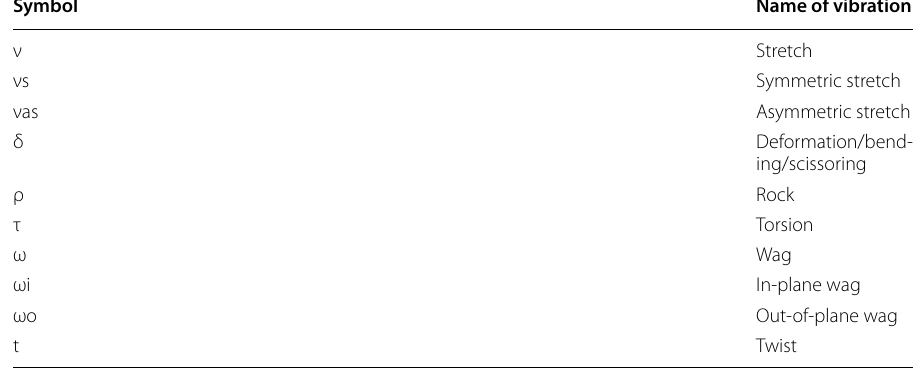
Table 1 Symbols used to identify the sub-classes of vibrations